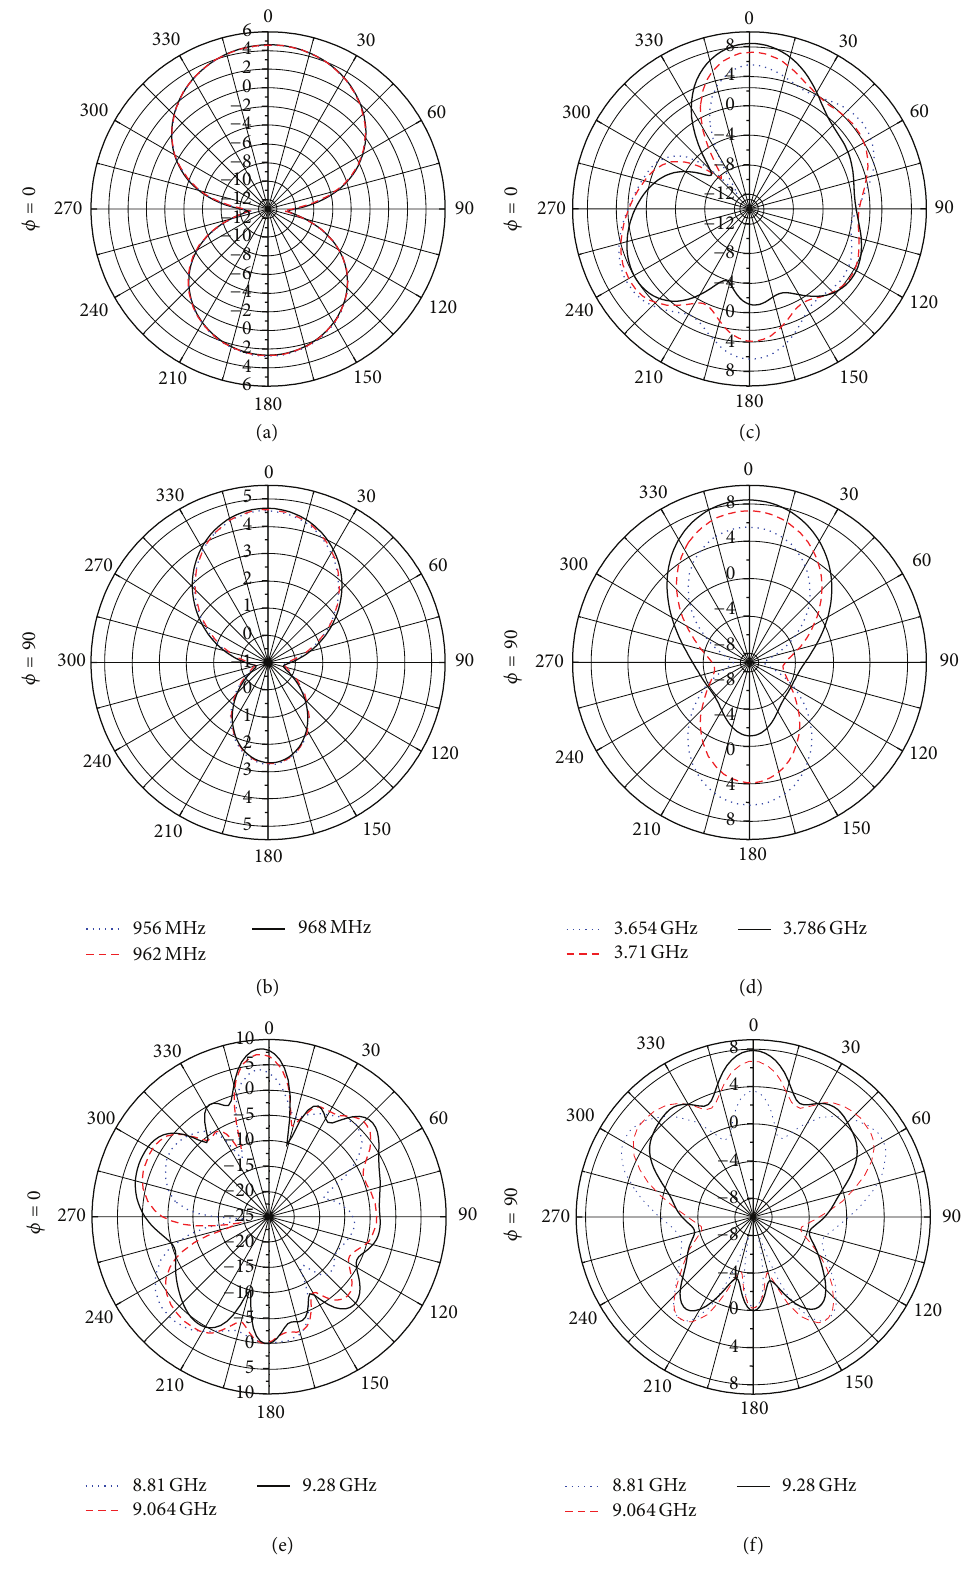
Figure 8: The radiation patterns of the two-layer Sierpinski patch antenna. (a) The radiation pattern of the first band (phi = 0). (b) The radiation pattern of the first band (phi = 90). (c) The radiation pattern of the second band (phi = 0). (d) The radiation pattern of the second band (phi = 90). (e) The radiation pattern of the third band (phi = 0). (f) The radiation pattern of the third band (phi =